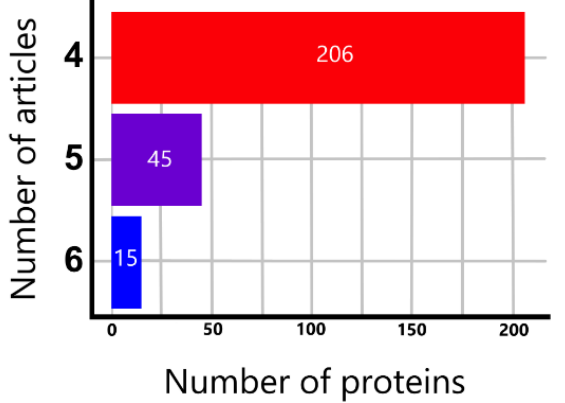
Figure 1. The number of significantly regulated proteins was reported consistently by 4, 5, and 6 MS-based articles. 6 MS-based articles.